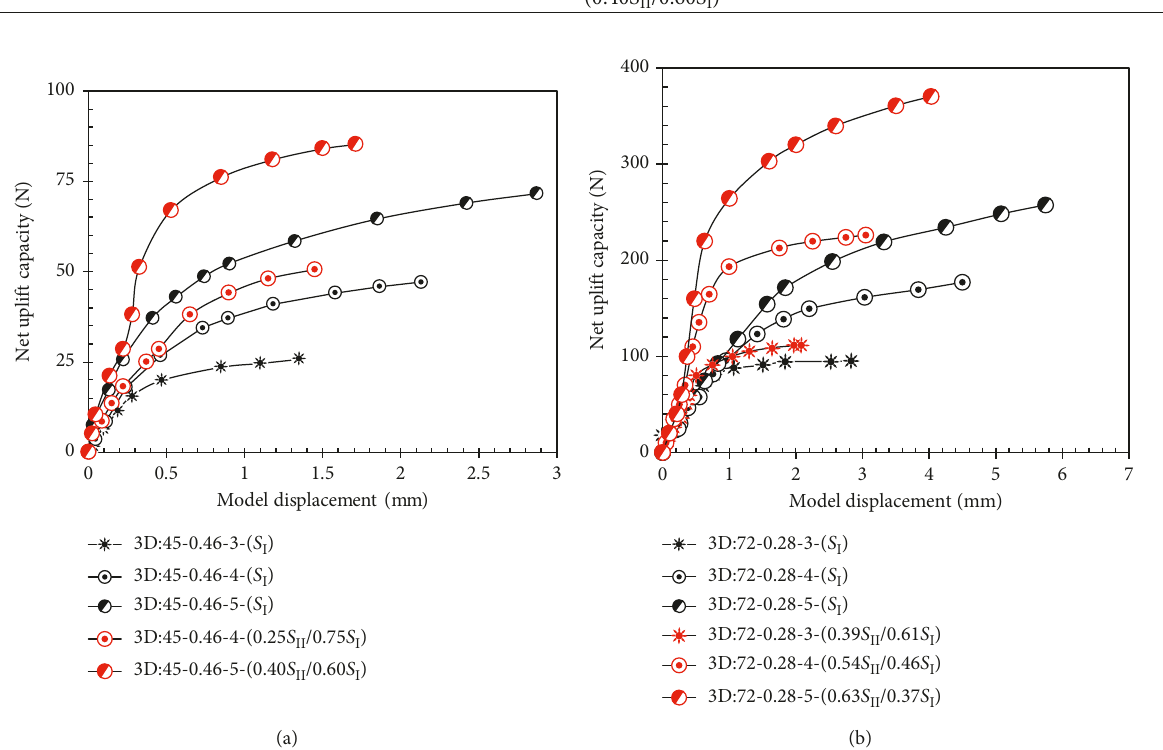
Figure 4: Comparison of net uplift capacity vs. model displacement (a) for model 3D:45-0.46 and (b) for model 3D:72-0.28, both in homogeneous ( S I ) and layered ( S II / S I ) sand deposits at L / D b